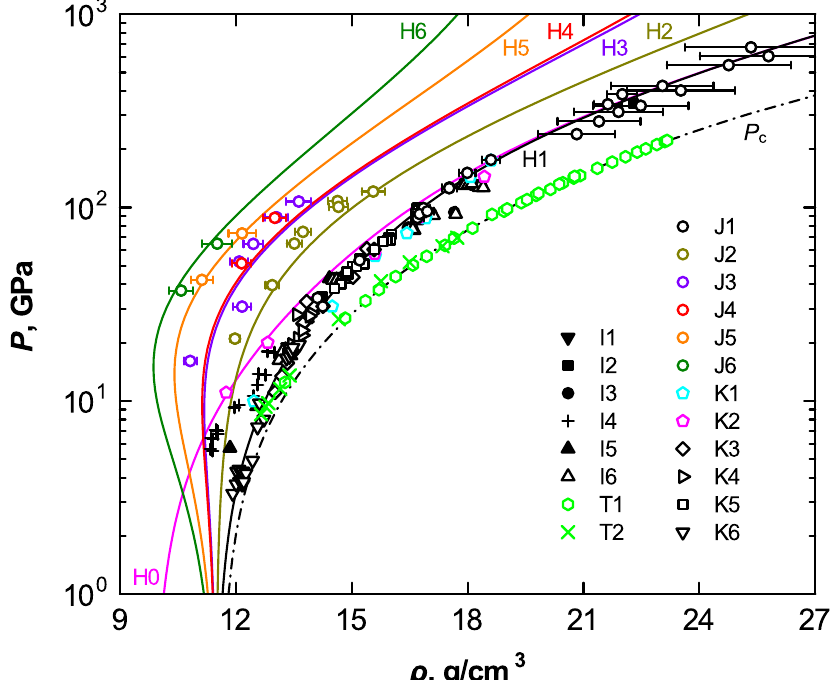
Figure 4. Diagram of states of bismuth under cold compression ( P c ) and shock loading of samples of different initial densities and initial temperatures at an initial normal pressure (H0 to H6): T1 and T2—data from static experiments at high pressure and room temperature for the bcc phase (T1—[53,54]; T2—[51,52]); the rest of the designations are the same as in Figure